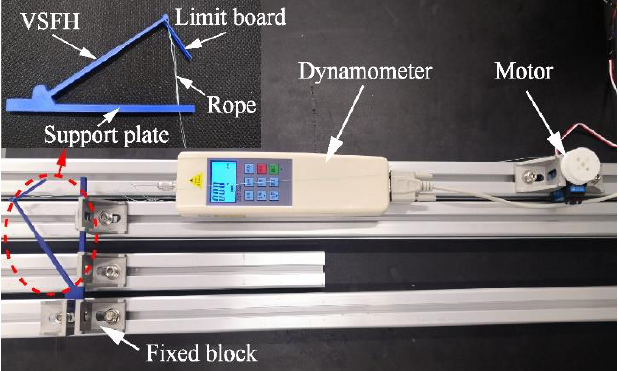
Figure 7. Experiment setup for measuring the stretching force of VSFH.